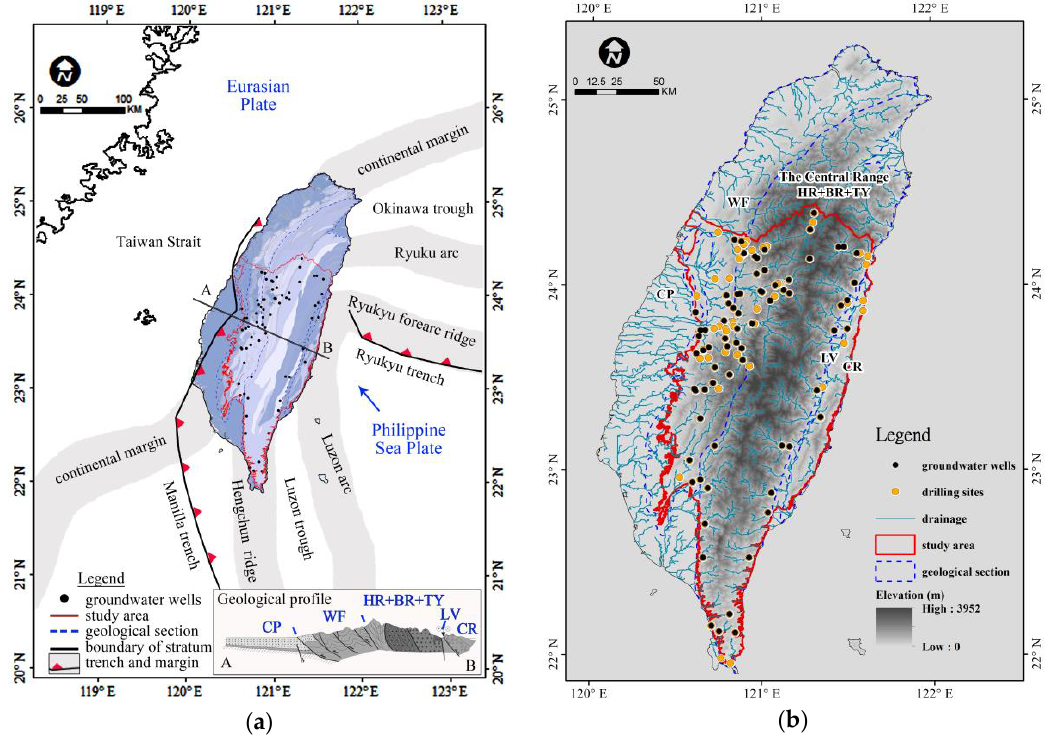
Figure 3. Distribution of study area and in-situ sites implemented from 2010 to 2017. ( a ) Geology of Taiwan (after [7,59]); ( b ) topography of Taiwan. From east to west, Taiwan is delineated by major tectonic structures and faults, including the Coastal Range (CR), Longitudinal Valley (LV), Taroko and Yuli Belt (TY) of the East Central Range, the Hsueshan Range (HS) and the Backbone Range (BR) of the West Central Range, the Western Foothills (WF), and the Coastal Plain (CP). The major drainage in each watershed was extracted by a threshold value of flow accumulation.